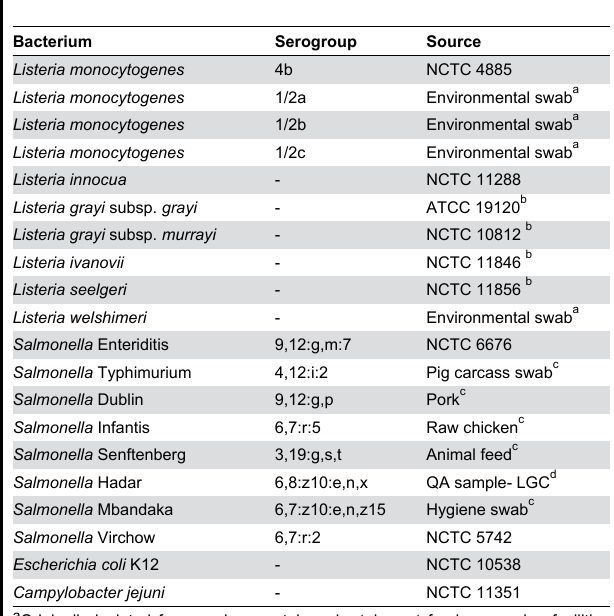
Table 1. Bacterial strains employed in this